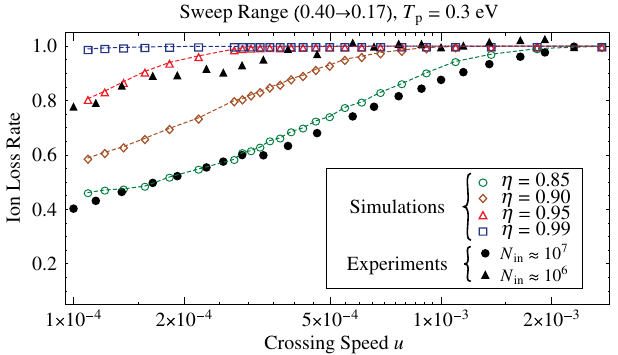
FIG. 14. Comparison of measurement data with the corre- sponding ion-loss simulations. The experimental results in Fig. 10 are replotted with filled circles ( N in (cid:3) 10 7 ) and triangles ( N in (cid:3) 10 6 ). The ordinate (Ion-Loss Rate) stands for the final ion number divided by the initial. The initial plasma temperature is chosen to be 0.3 eV in all simulations that consider four different values of (cid:3) , i.e., (cid:3) ¼ 0 : 85 (circle), 0.9 (diamond), 0.95 (triangle), and 0.99 (square).